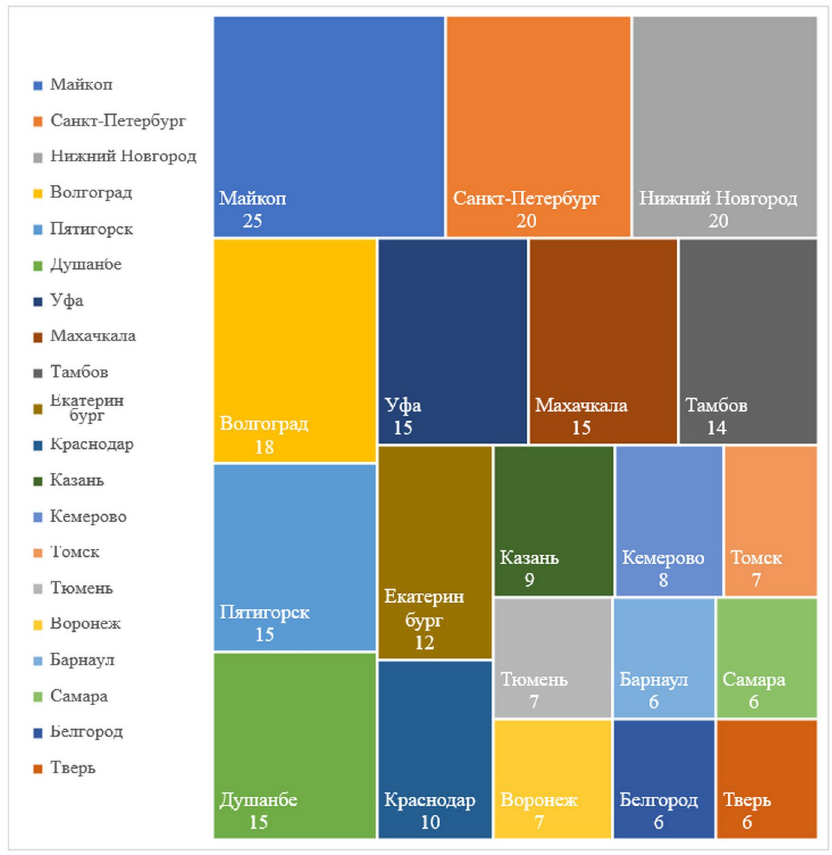
Рисунок 4 - География защит диссертационных исследований концептов, выполненных с 2012 по 2022 гг. (места 2-21 составленного